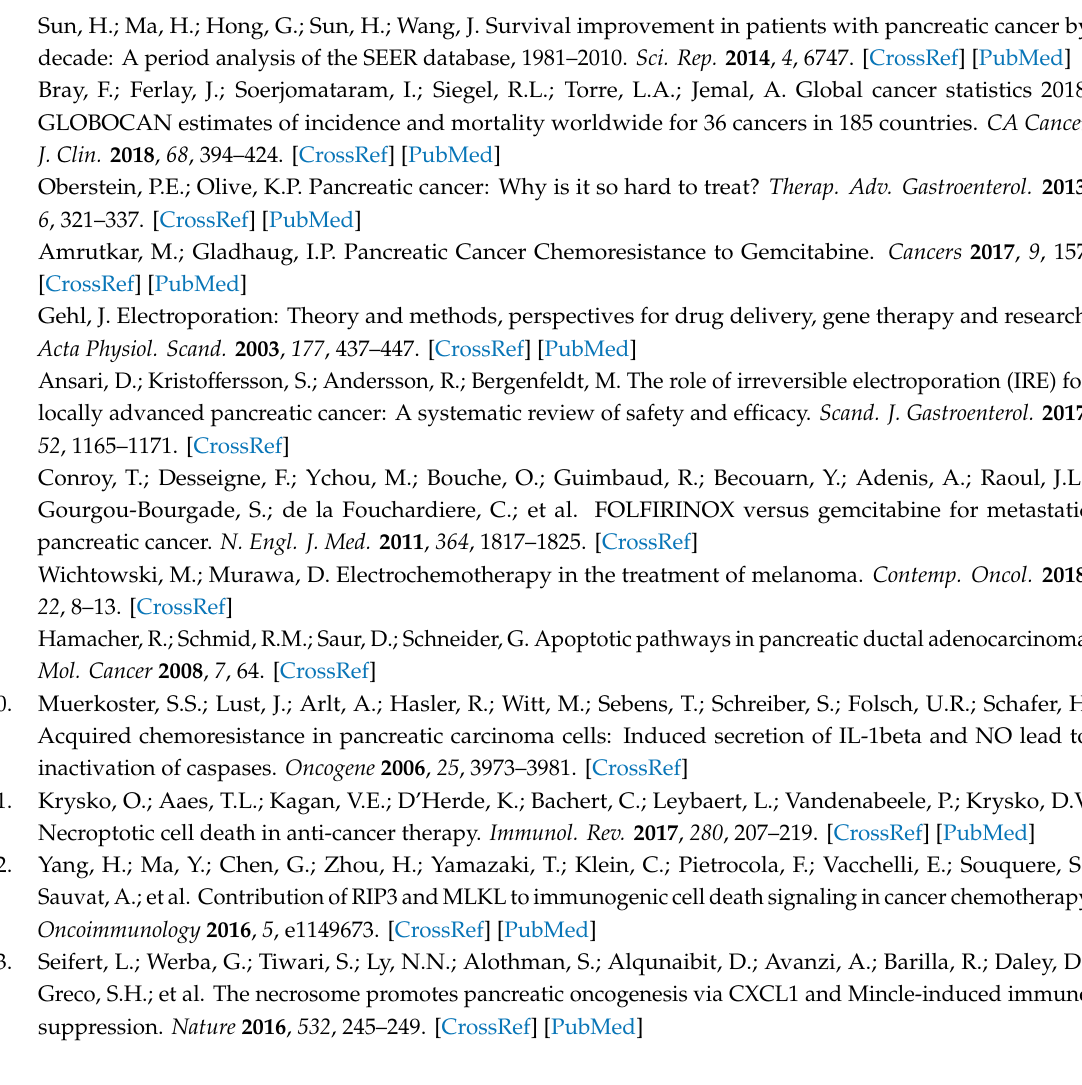
Figure S1: The viability of pancreatic cancer cells is decreased 24 h following ECT treatment. Figure S2: Analysis of PS exposure versus cell permeability using Annexin V and PI staining by flow cytometry. Figure S3 PANC-1 cells undergoing cell death following MTX treatment move to an Annexin V positive stage whilst cells following Bleomycin ECT move directly to a double-positive (Annexin V +/ PI + ) state. Figure S4 Necrostatin-1 is su ffi cient to rescue cell morphology from ECT-mediated alterations. Figure S5 NSA inhibits ECT-mediated death in PANC-1 cells and improves their